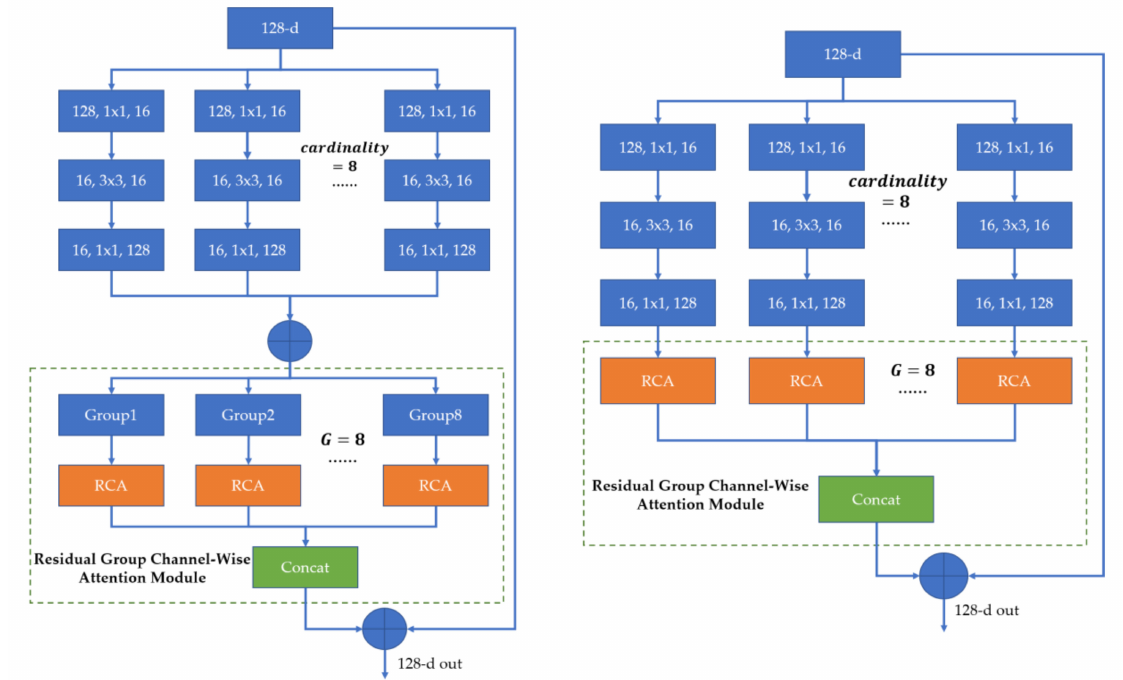
Figure 6. The structure of the residual group channel-wise attention (RGCA) module before simplification ( left ) and after simplification ( right ).